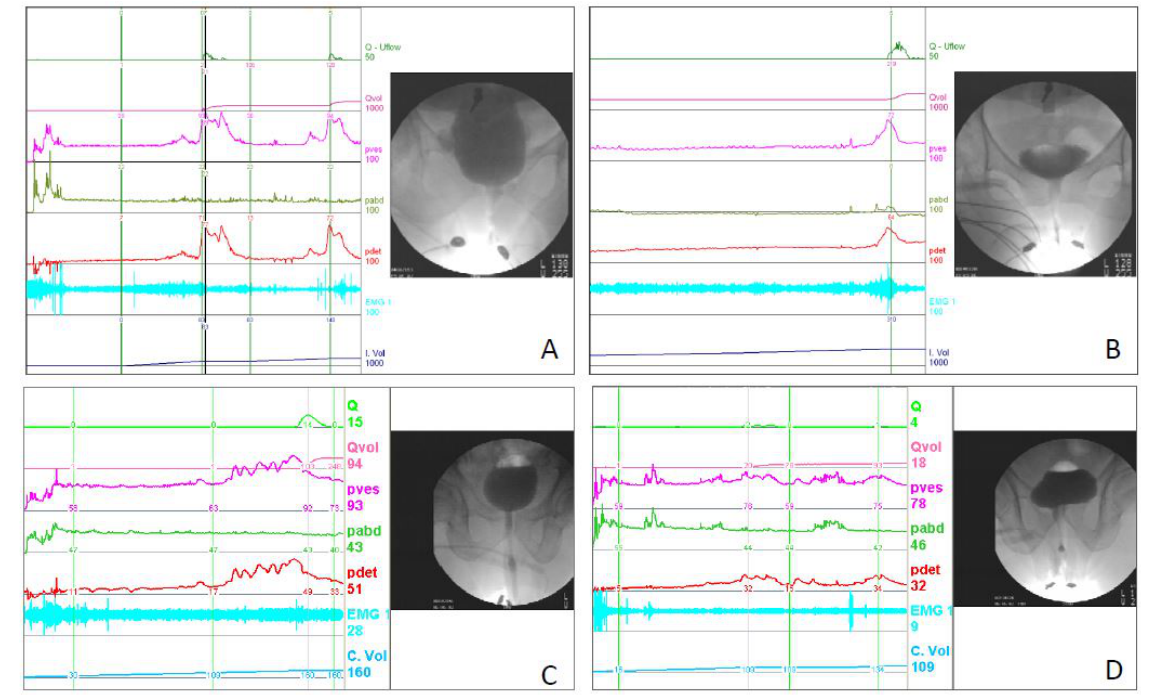
Figure 2. The videourodynamic tracings of dysfunctional voiding: ( A ) dysfunctional voiding in a woman with cerebrovascular accident, ( B ) detrusor overactivity and dysfunctional voiding in a woman with mild dementia, ( C ) poor external sphincter relaxation in a man with Parkinson’s disease, and ( D ) detrusor overactivity with low detrusor contractility and coordinated external sphincter in a woman with senile dementia. Abbreviations: Q: flow rate, Qvol: voided volume, Pves: intravesicle pressure, Pabd: intra-abdominal pressure, Pdet: voiding detrusor pressure, EMG: electromyogram, C. Vol: cumulated infused volume.